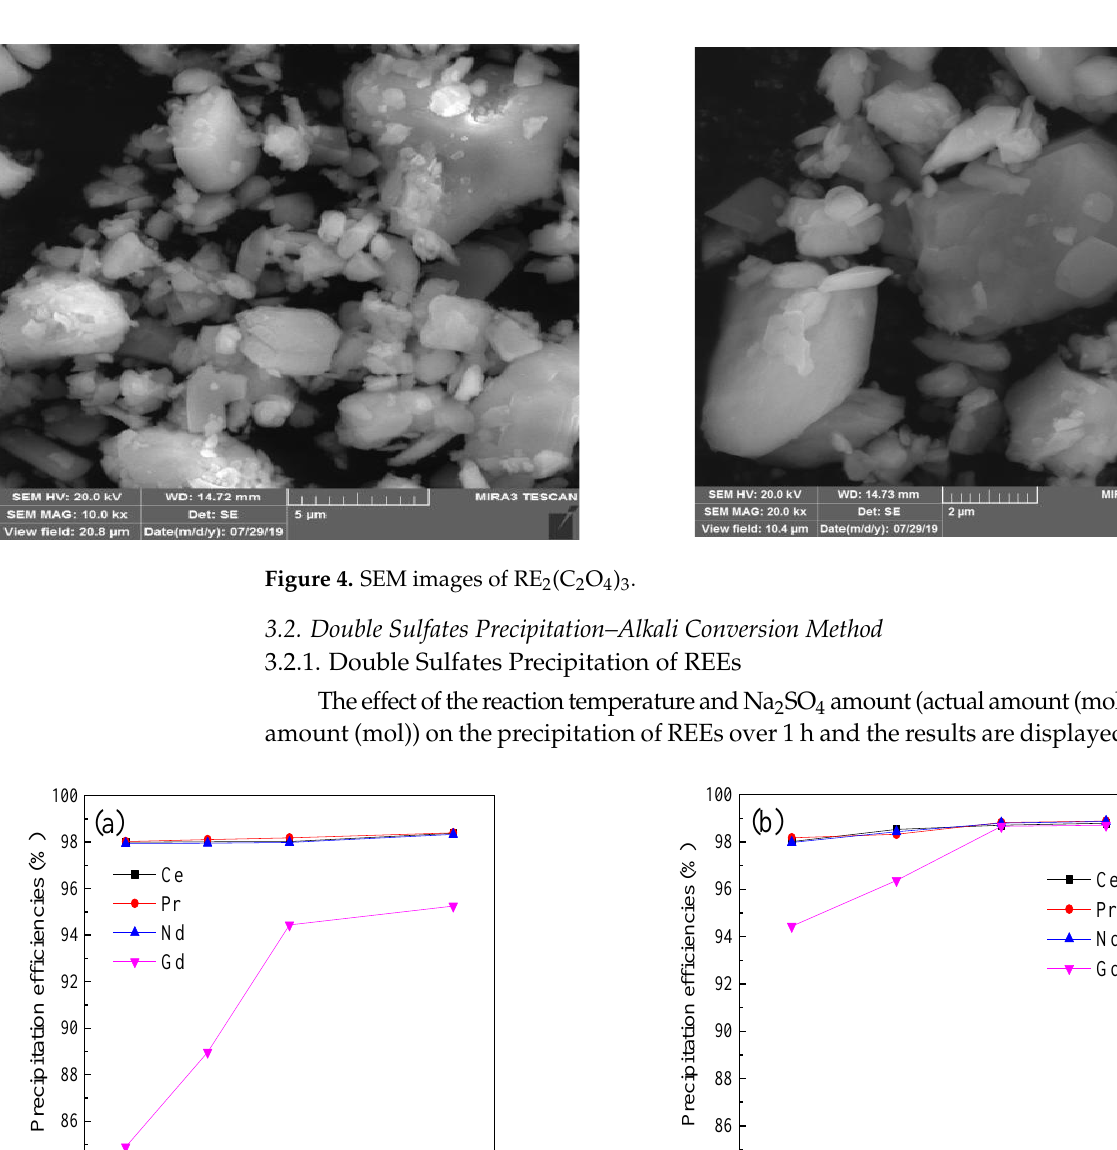
Figure 3. XRD pattern of RE 2 (C 2 O 4 ) 3 .